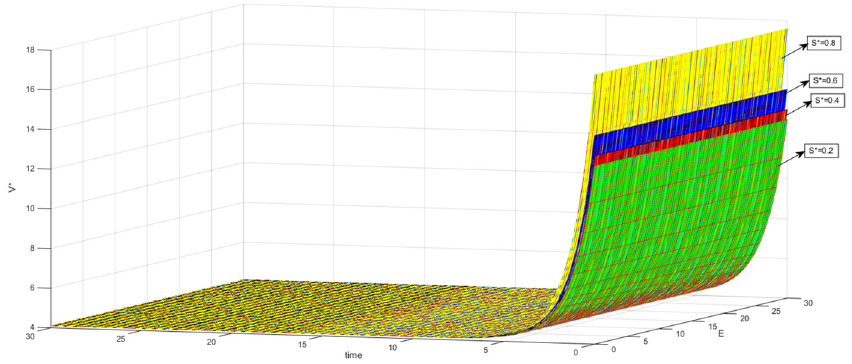
Figure 5: The change of enterprise ’ s optimal bene fi t under di ff erent optimal subsidy